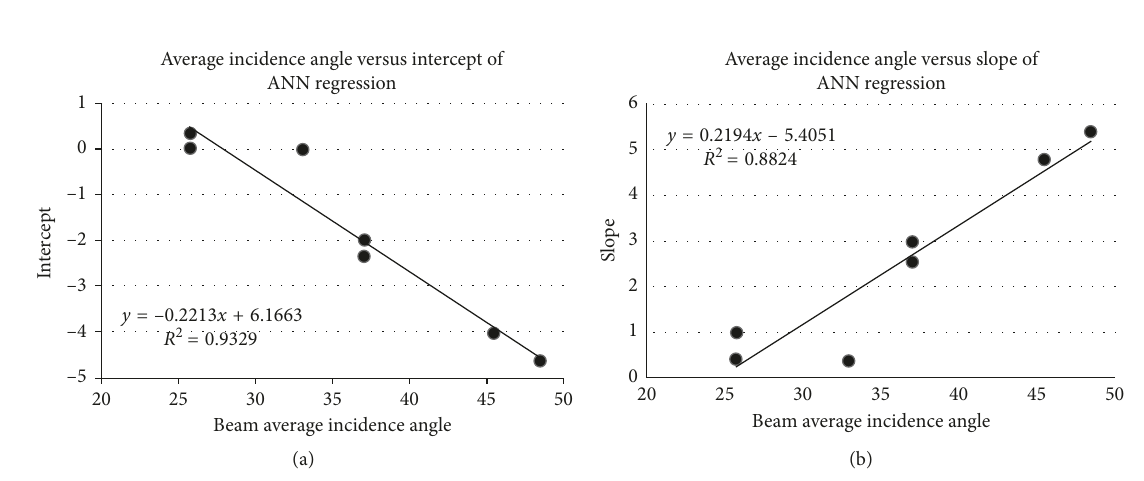
Figure 6: Beam mode incidence angle correlations to slope and intercept values calculated for ANN